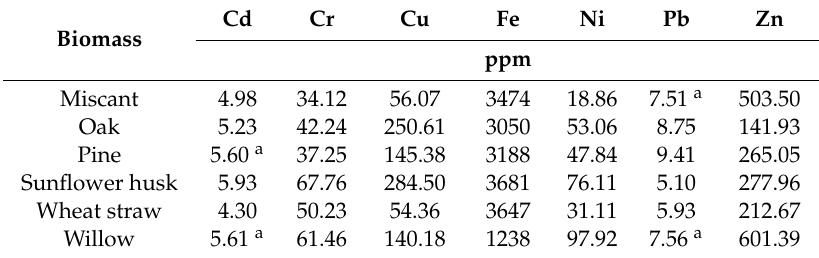
Table 2. Results of detailed comparisons of average content of individual trace elements in the tested biomass with the Tukey test at the significance level of 0.05.